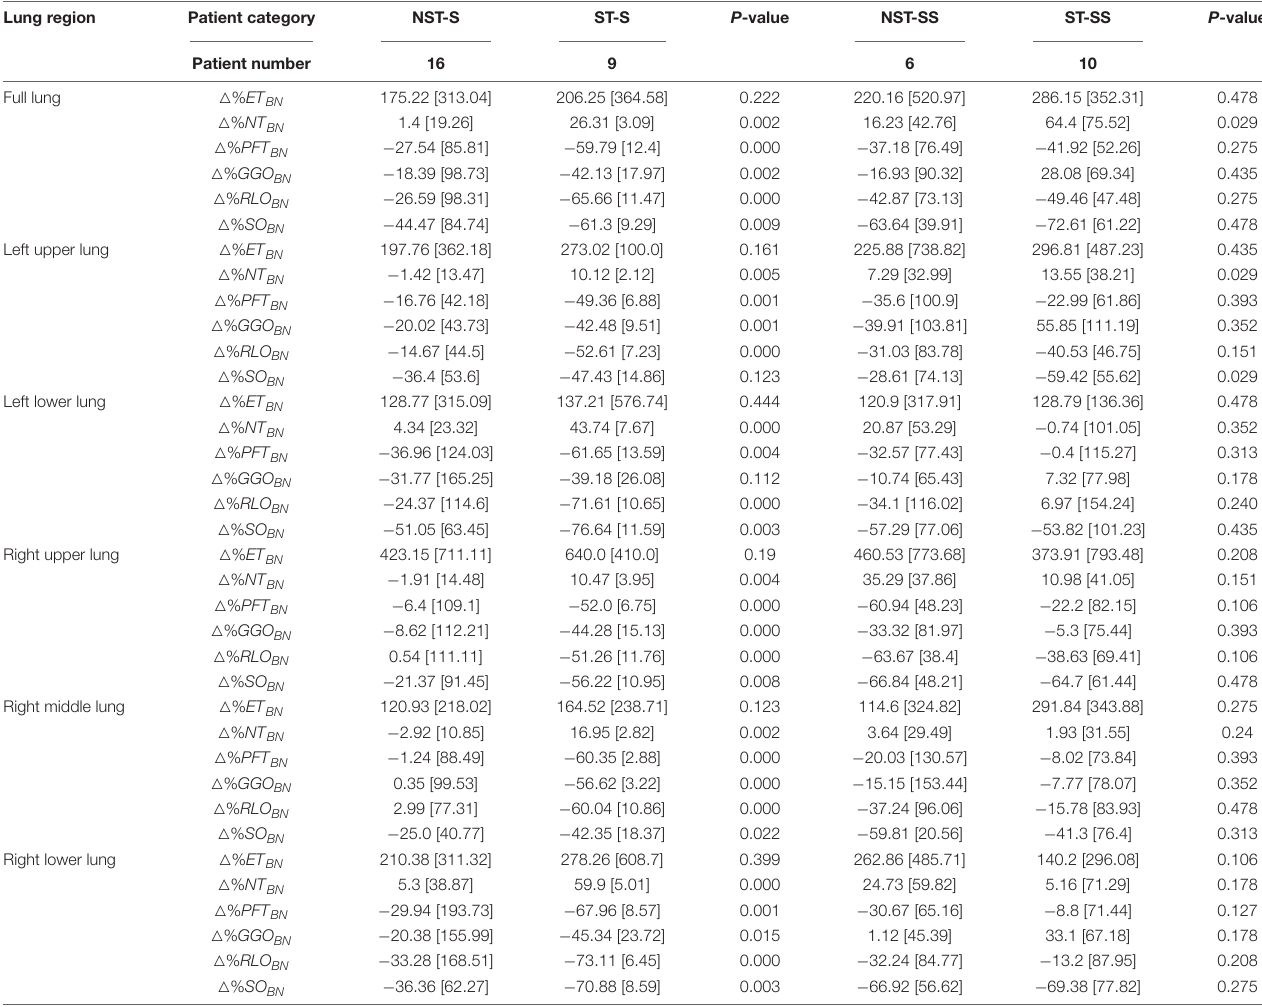
TABLE 2 | The changes of normalized CT quantitative results after 5-CT-cycle treating. Lung